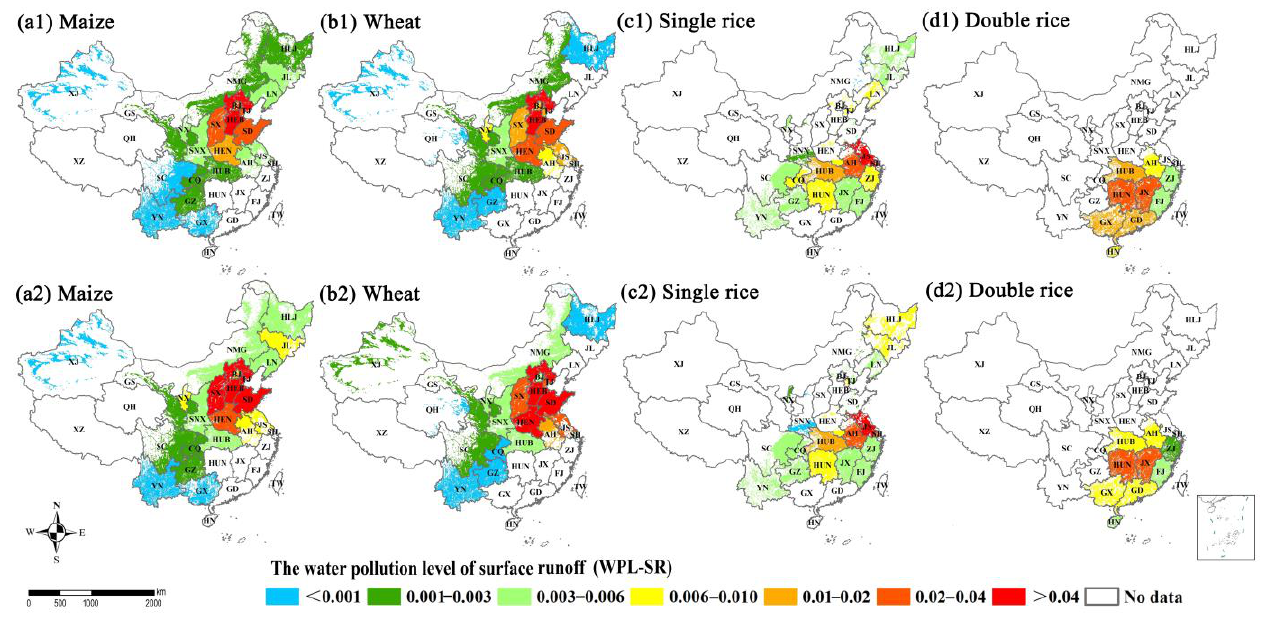
Figure 7. The water pollution level of surface runoff losses (WPL-SR) between 2004 – 2008 and 2014 – 2018 for ( a1 , a2 ) maize, ( b1 , b2 ) wheat, ( c1 , c2 ) single rice and ( d1 , d2 ) double rice at provincial scale in China’s farmlands, respectively.